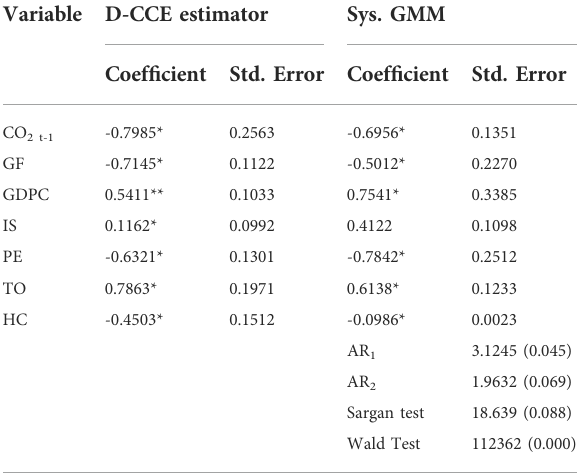
TABLE 7 Outcomes of D-CCE and system GMM estimators. Variable D-CCE